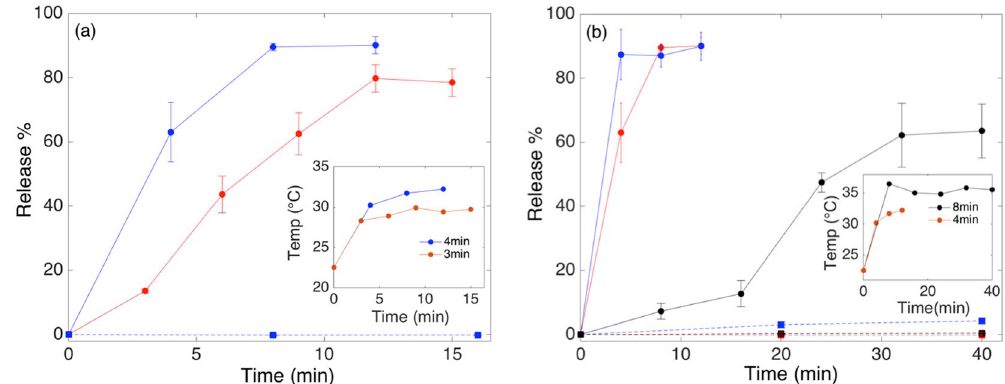
Figure 5. ( a ) Calcein release kinetics of PEGylated DPPC ( T m = 41 °C) vesicles comprising 4 wt% SPION exposed to 3 min AMF pulses (solid red) and 4 min AMF pulses (solid blue). The averages and standard errors of the mean are shown for four different measurements on two independent samples. ( b ) Release kinetics for 4 wt% SPION PEGylated magnetoliposomes exposed to 4 min AMF pulses for MPPC ( T m = 35 °C) (solid blue) and DPPC (solid red) and 8 min AMF pulses for DSPC ( T m = 55 °C) (solid black). The error bars show the standard errors of three (blue), four (red) and two (black) different measurements on two independent samples. The dotted lines represent the passive release measured during the same time for the sample of the respective color. The insets show the bulk temperature during actuation of the respective sample, which is attributed to Joule heating of the